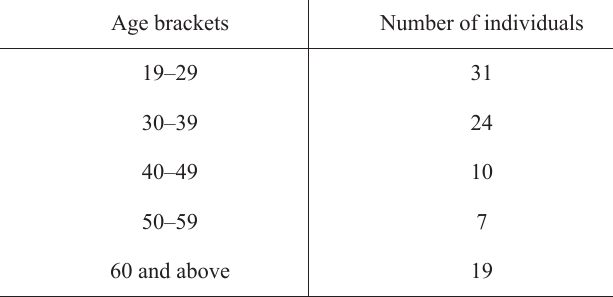
Table 1. Ages of informants Age